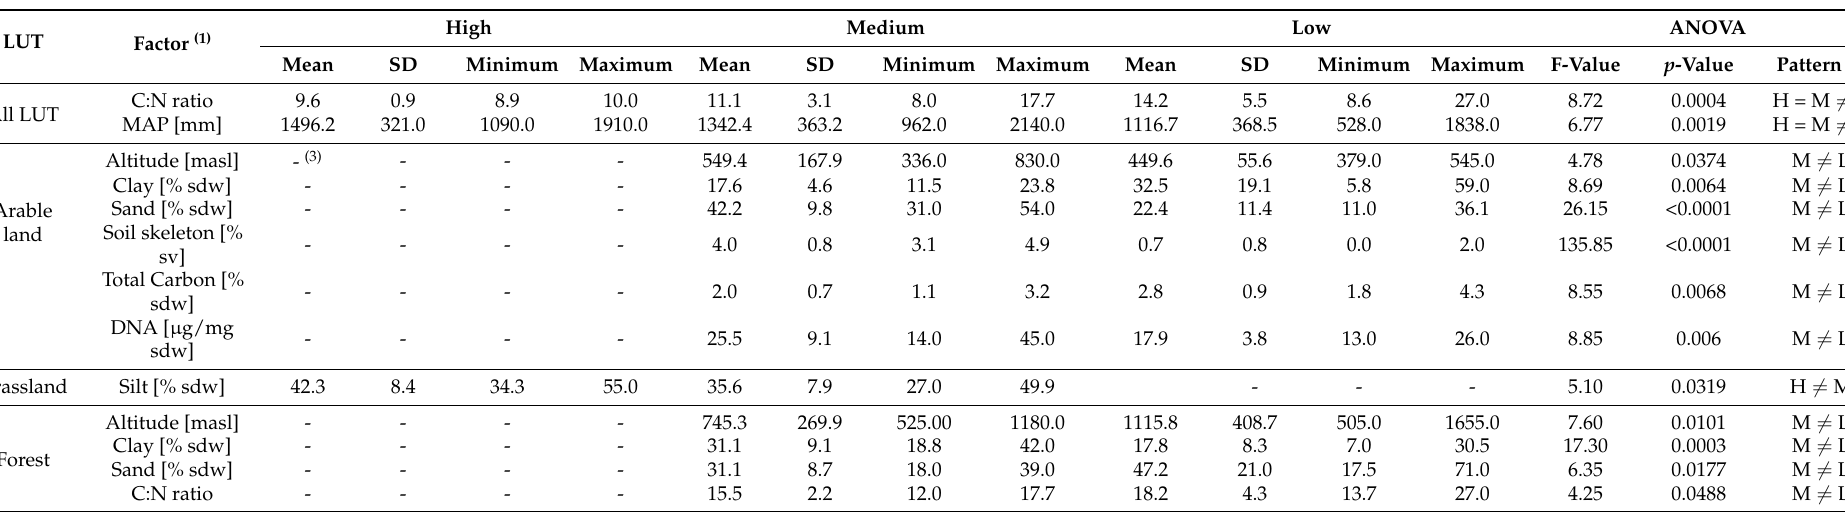
Table 1. Summary of soil and environmental factors that differ significantly among Metarhizium spp. abundance groups (high, medium, and low) and between and within land-use types